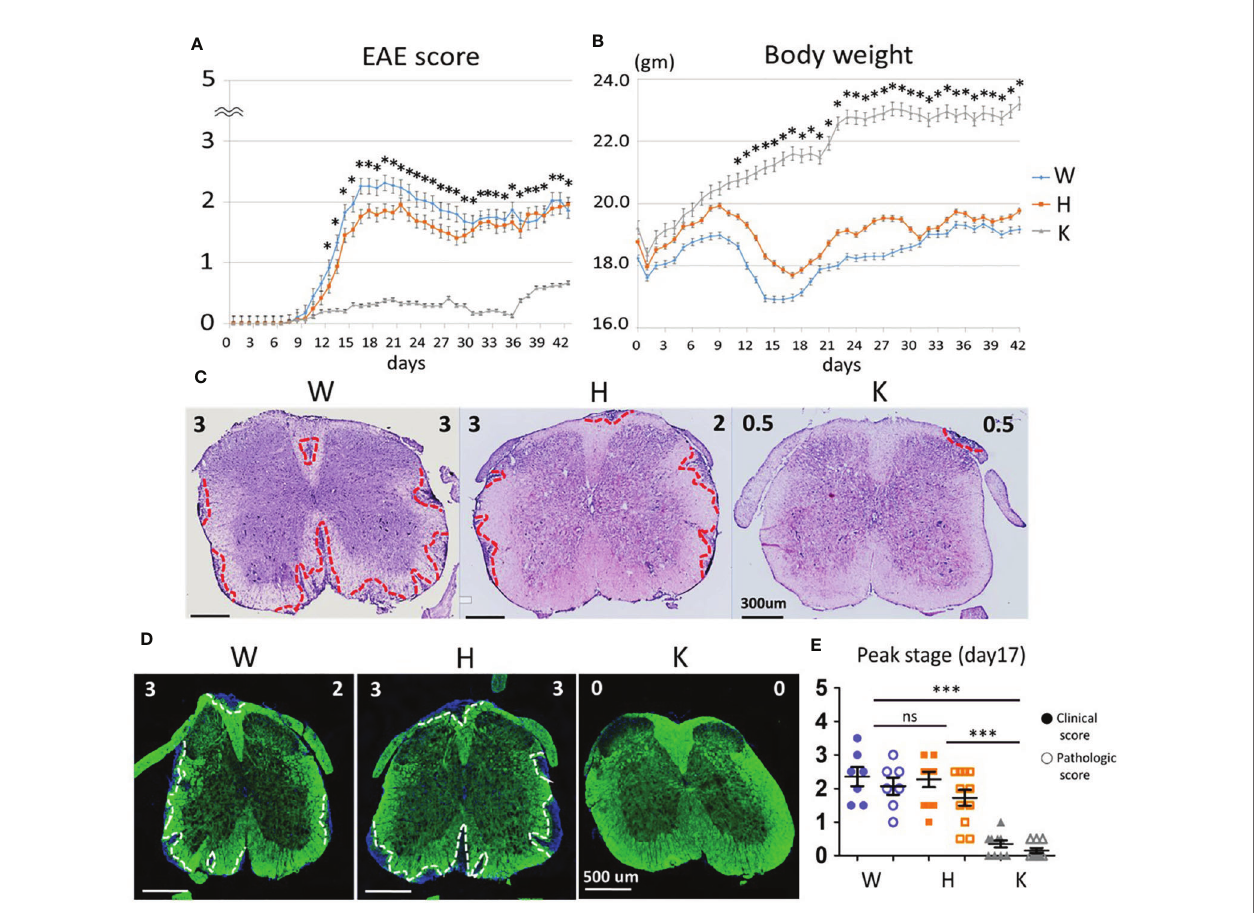
FIGURE 1 | Nox2-de fi cient mice show less in fl ammatory in fi ltration, demyelination at lumbar spinal cord after EAE induction on disease peak (17 dpi). (A) EAE disease score and (B) Body weight change among three genotypes (mean ± SEM) [n = 33 (W), 63 (H), 46 (K)]. (C) Representative Hematoxylin and Eosin stains and (D) Fluoromyelin staining of lumbar spinal cord at the peak of EAE score (17 dpi). Left upper corner score: clinical score. Right upper corner score: pathologic score. The red dot lines outline the areas of leukocytes in fi ltration while the white dot lines outline the areas of demyelination. (E) Clinical score and pathologic score on day 17 based on the results of H&E stains [n = 7 (W), 11 (H), 10 (K)]. Genotype: W, Nox2 +/+ ; H, Nox2 +/ − ; K, Nox2 − / − . Formalin- fi xed frozen section: 10 m m; spinal cord level: lumbar fourth, myelin: green; DAPI: blue. p value: *** < 0.001, * < 0.05; ns, not signi fi